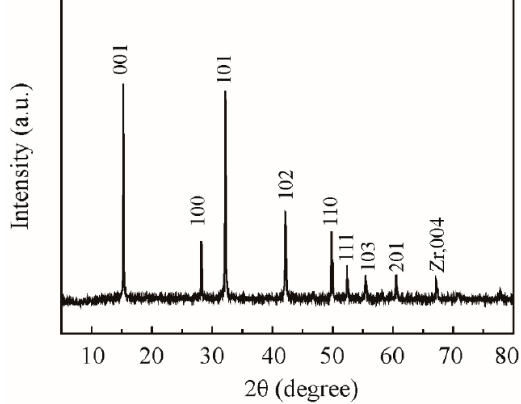
Figure 2. XRD pattern of lamellar ZrS 2 nanobelts .